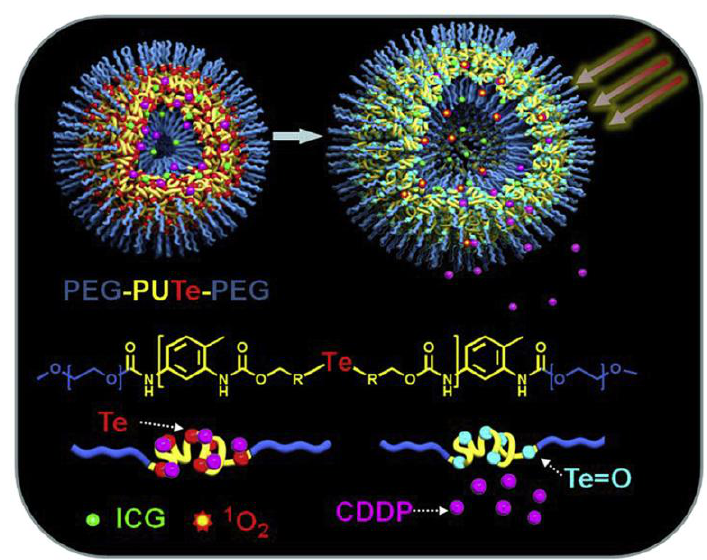
Figure 9. NIR light-triggered release of cisplatin (here abbreviated with CDDP) and indocyanine green (ICG) from an amphiphilic block copolymer micelle; stimulation of ICG leads to the formation of 1 O 2 and the oxidation of tellurium, thereby drastically weakening the tellurium-cisplatin coordination. Reprinted from Ref. [172] with permission from Elsevier.